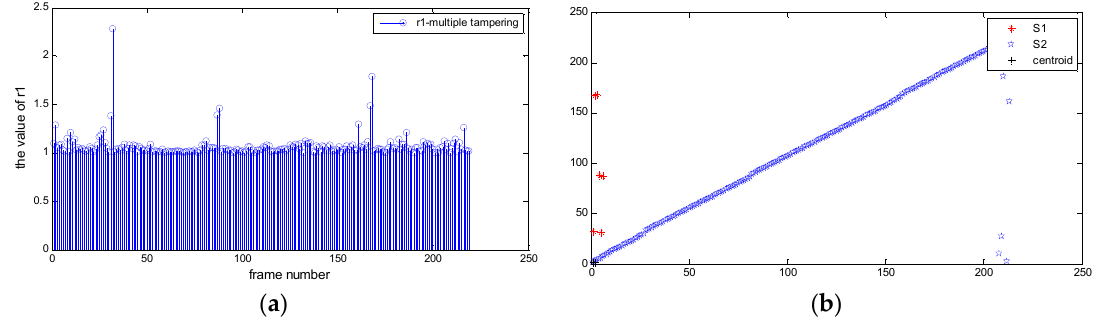
Figure 10. Clustering results of multiple tampering. ( a ) The curve of ∆r1 ; ( b ) clustering results.